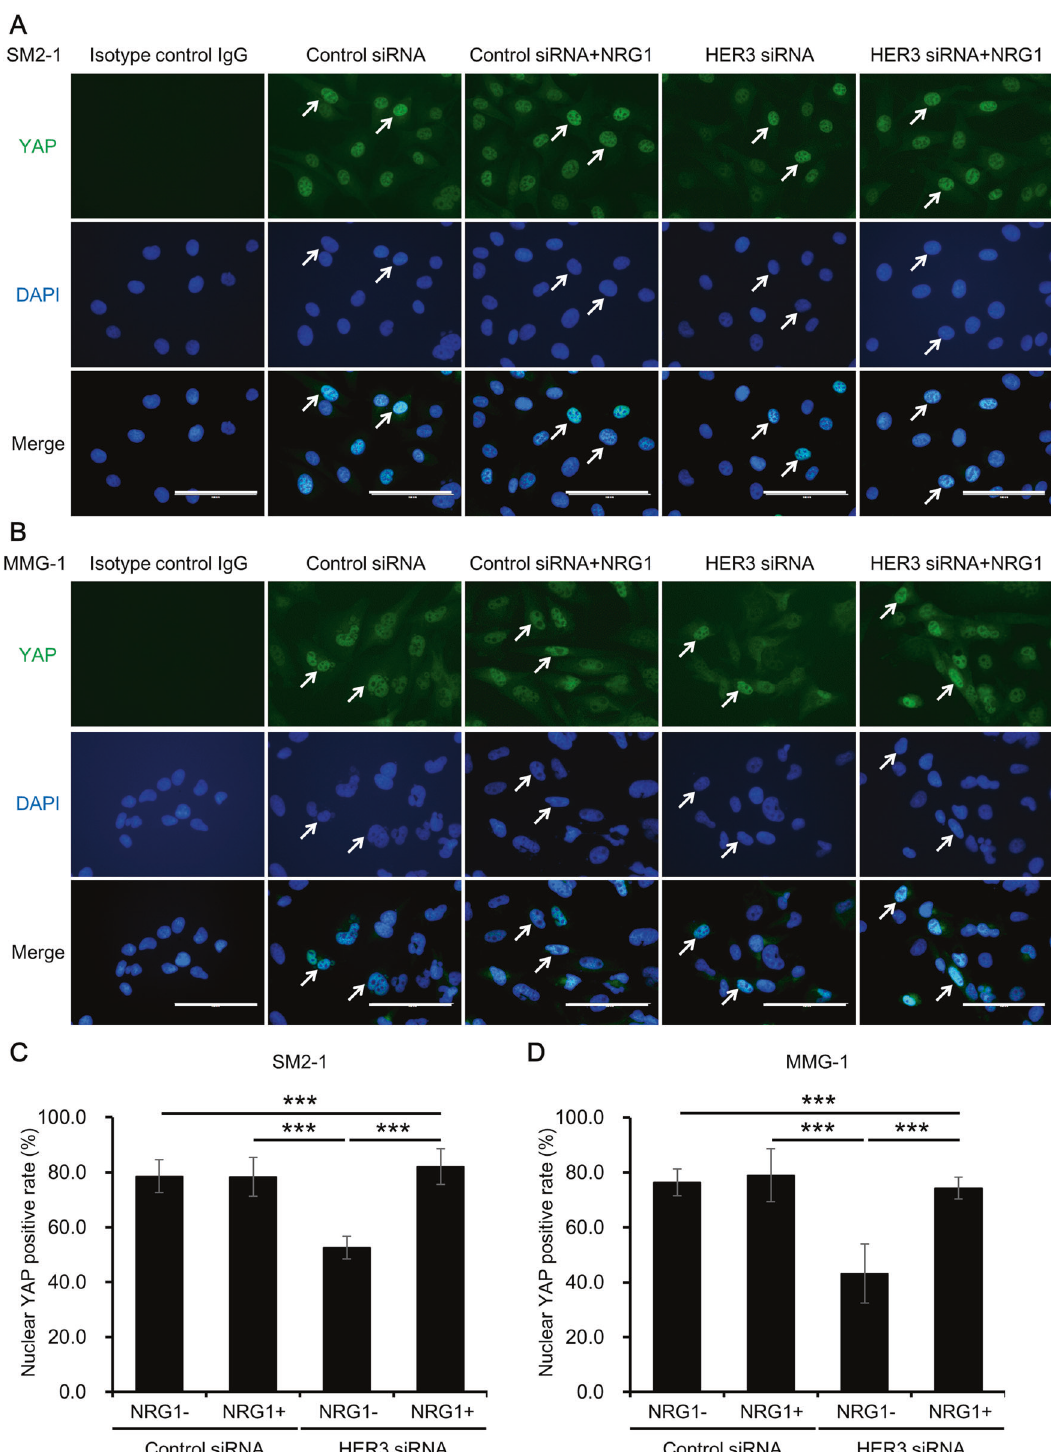
Fig. 5 Effect of HER3 knockdown and reactivation on the localization of YAP. AM cells were transfected with control or HER3 siRNA in the presence of vehicle control or NRG1 (10 ng/ml) and evaluated for YAP nuclear translocation. Experiments were independently repeated three times and representative immunocytochemical images of ( A ) SM2-1 and ( B ) MMG-1 cells are shown. Arrows indicate representative cells with nuclear YAP. Scale bars = 100 μ m. Mean ± SD of nuclear YAP-positive rate in ( C ) SM2-1 and ( D ) MMG-1 cells. Experiments were independently repeated three times and three images were captured from different fi elds of each well. Nuclear YAP-positive rate was calculated by dividing the number of nuclear YAP-positive cells by the total number of DAPI-positive cells from the three different fi elds. *** p < 0.001.